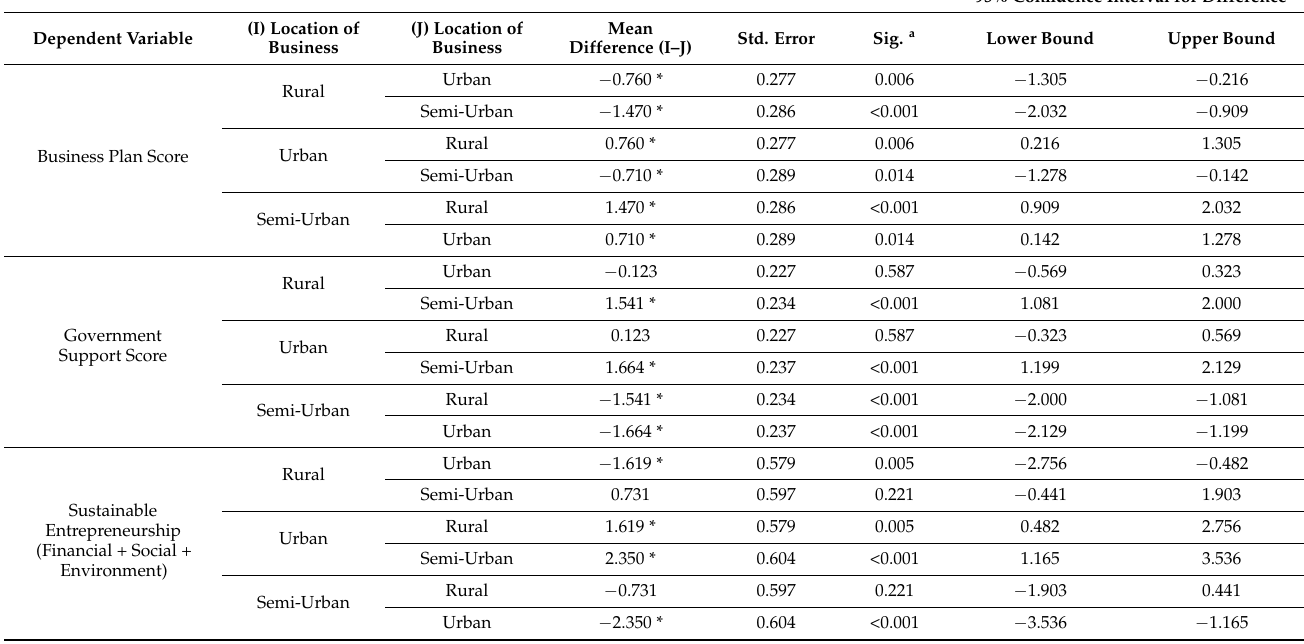
Table 12. Pairwise